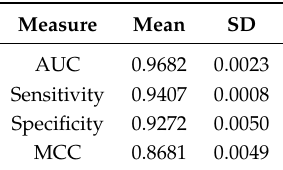
Table 1. Performance measures for the amino acid encoding with the highest sensitivity calculated for 60 repetitions of cross-validation.